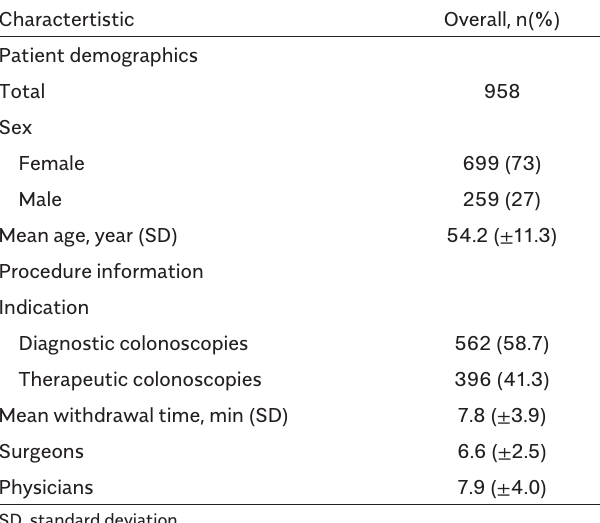
Table 1. Characteristics of Patients with Sessile Serrated Polyps (SSP) and Procedure Charactertistic